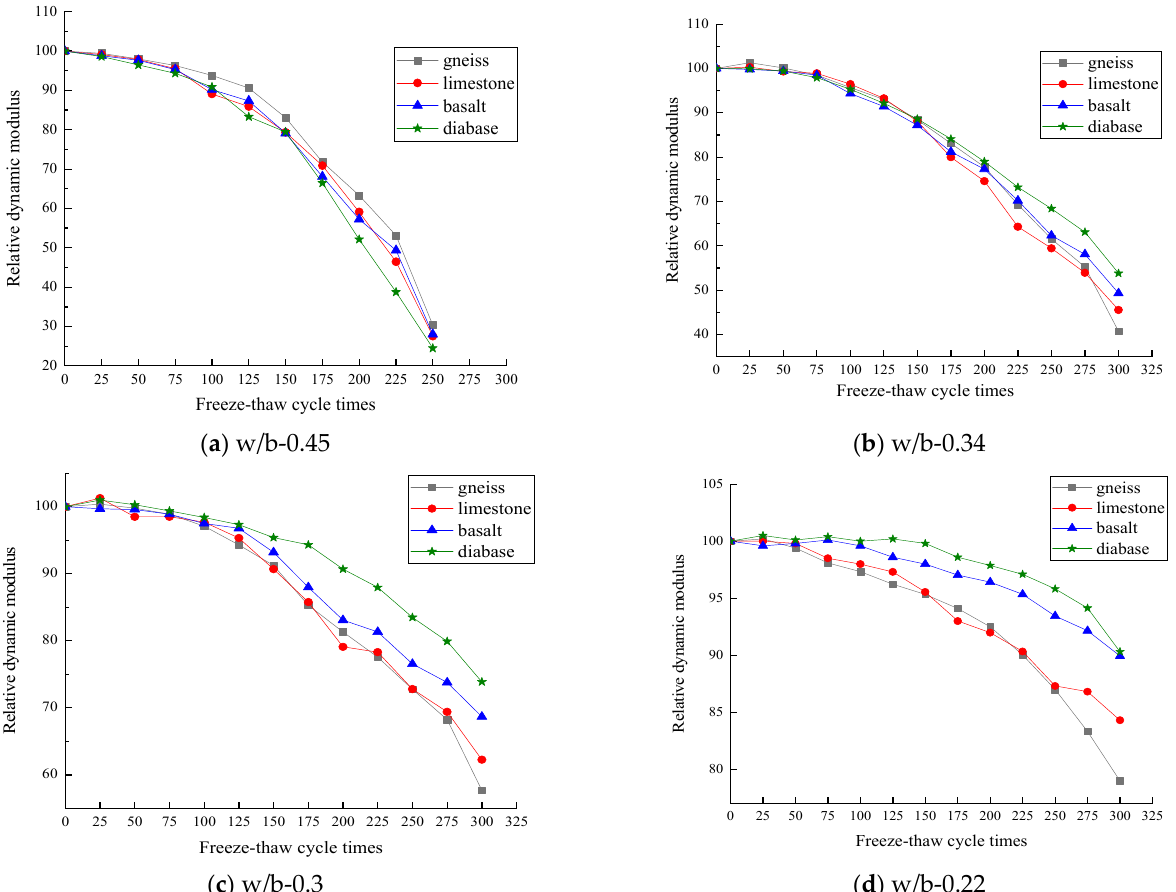
Figure 10. The relative dynamic modulus during freeze–thaw cycles: ( a ) water-binder ratio of 0.45; ( b ) water-binder ratio of 0.34; ( c ) water-binder ratio of 0.30 and ( d ) water-binder ratio of 0.22.